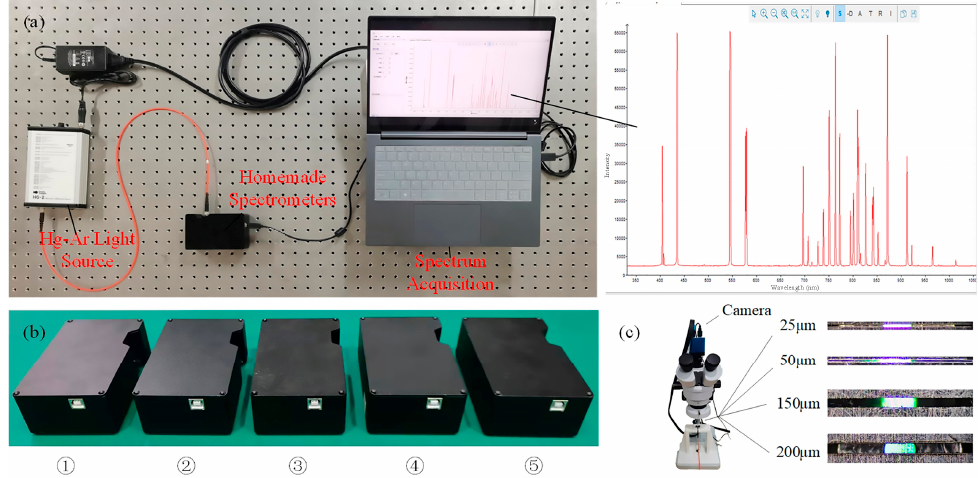
Figure 2. ( a ) Experimental platform. ( b ) Homemade Spectrometers. ( c ) Four sizes of slits used for the